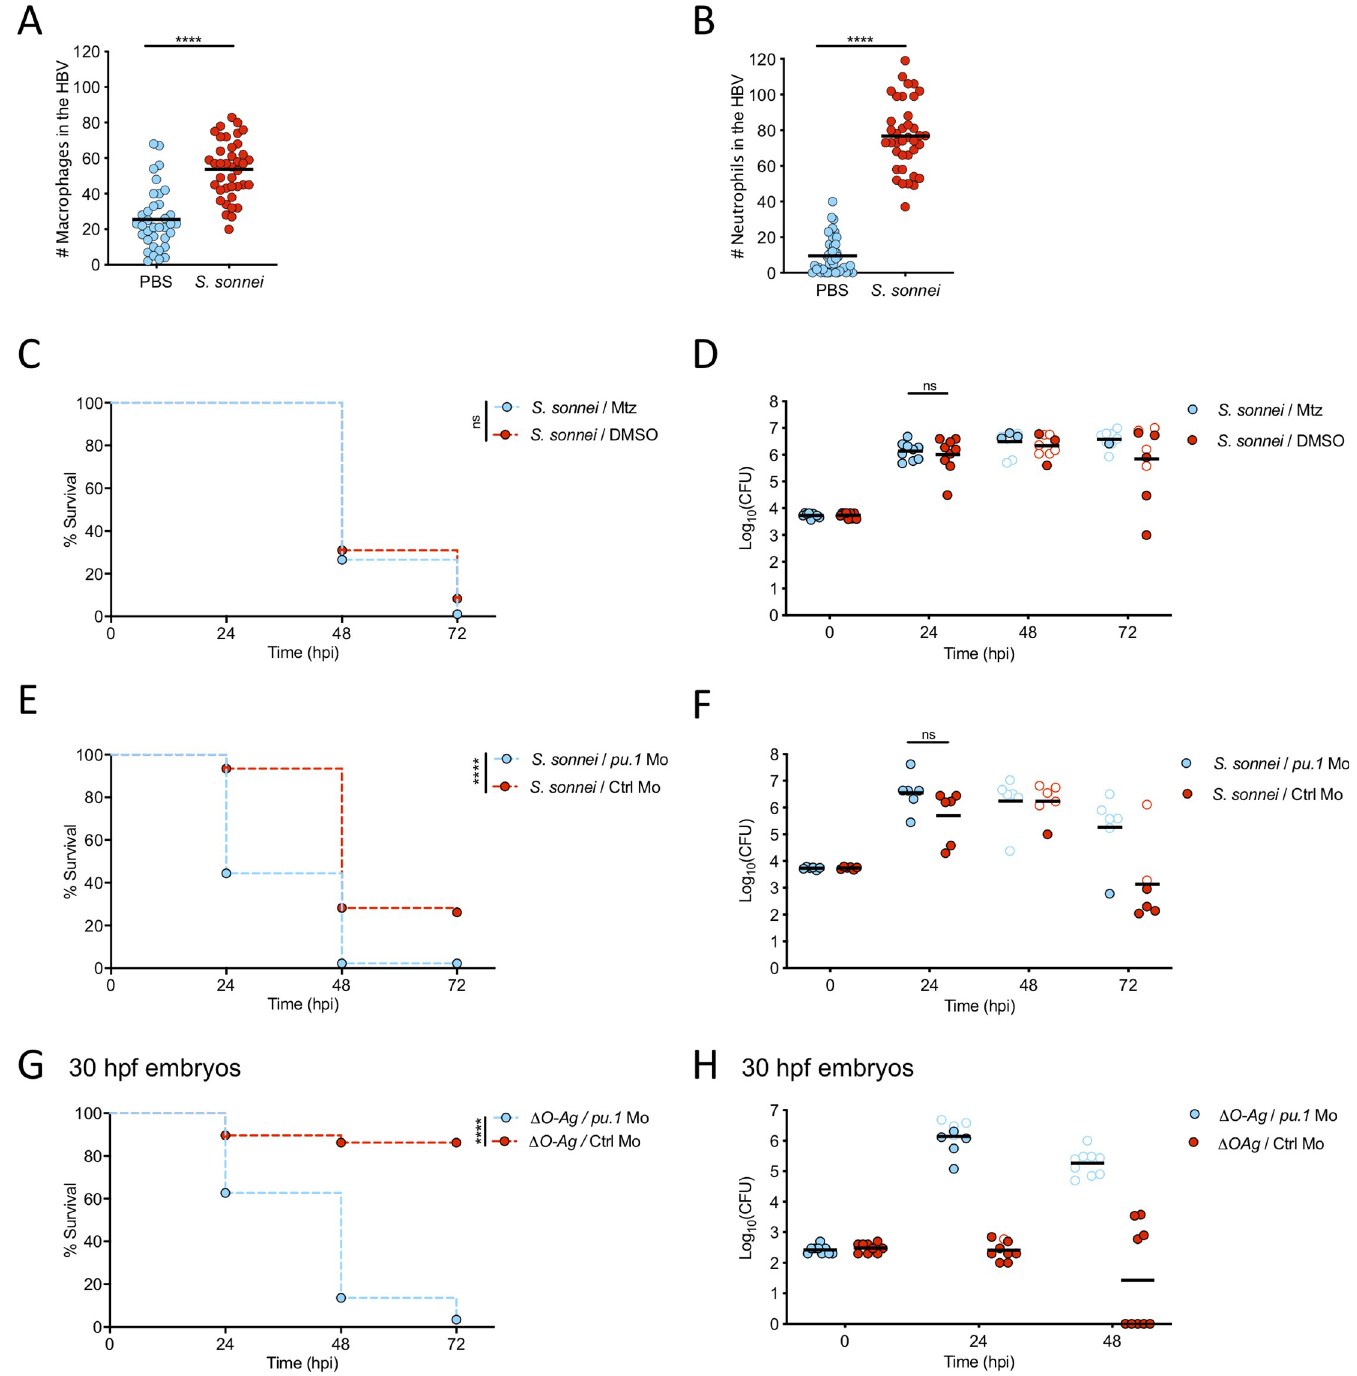
Fig 4. S . sonnei O-antigen can counteract clearance by zebrafish neutrophils. A,B. Macrophages and neutrophils are recruited to S . sonnei in vivo . Larvae of the Tg (mpeg1 : Gal4-FF) gl25 /Tg(UAS-E1b : nfsB . mCherry) c264 strain (labelling macrophages, A) or of the Tg(lyz : dsRed) nz50 strain (labelling neutrophils, B) were injected with PBS (blue) or S . sonne i (red) in the HBV. Recruitment was quantified from images at 6 hpi. Experiments are cumulative of 3 biological replicates. Statistics: two-tailed Mann- Whitney test; ���� p < 0.0001. C,D. Macrophage ablation does not increase susceptibility to S . sonnei . Survival curves (C) and Log 10 -transformed CFU counts (D) of Tg (mpeg1 : Gal4-FF) gl25 /Tg(UAS-E1b : nfsB . mCherry) c264 larvae which were treated with either Metronidazole (Mtz, macrophage ablated group, blue) or control DMSO vehicle (DMSO, red) prior to infection in the HBV with S . sonnei . Experiments are cumulative of 3 biological replicates. In D, full symbols represent live larvae and empty symbols represent larvae that at the plating timepoint had died within the last 16 hours. Statistics: Log-rank (Mantel-Cox) test (C); unpaired t-test on Log 10 - transformed data (D); ns, non-significant. E,F. pu . 1 morpholino knockdown increases susceptibility to S . sonnei . Survival curves (E) and Log 10 -transformed CFU